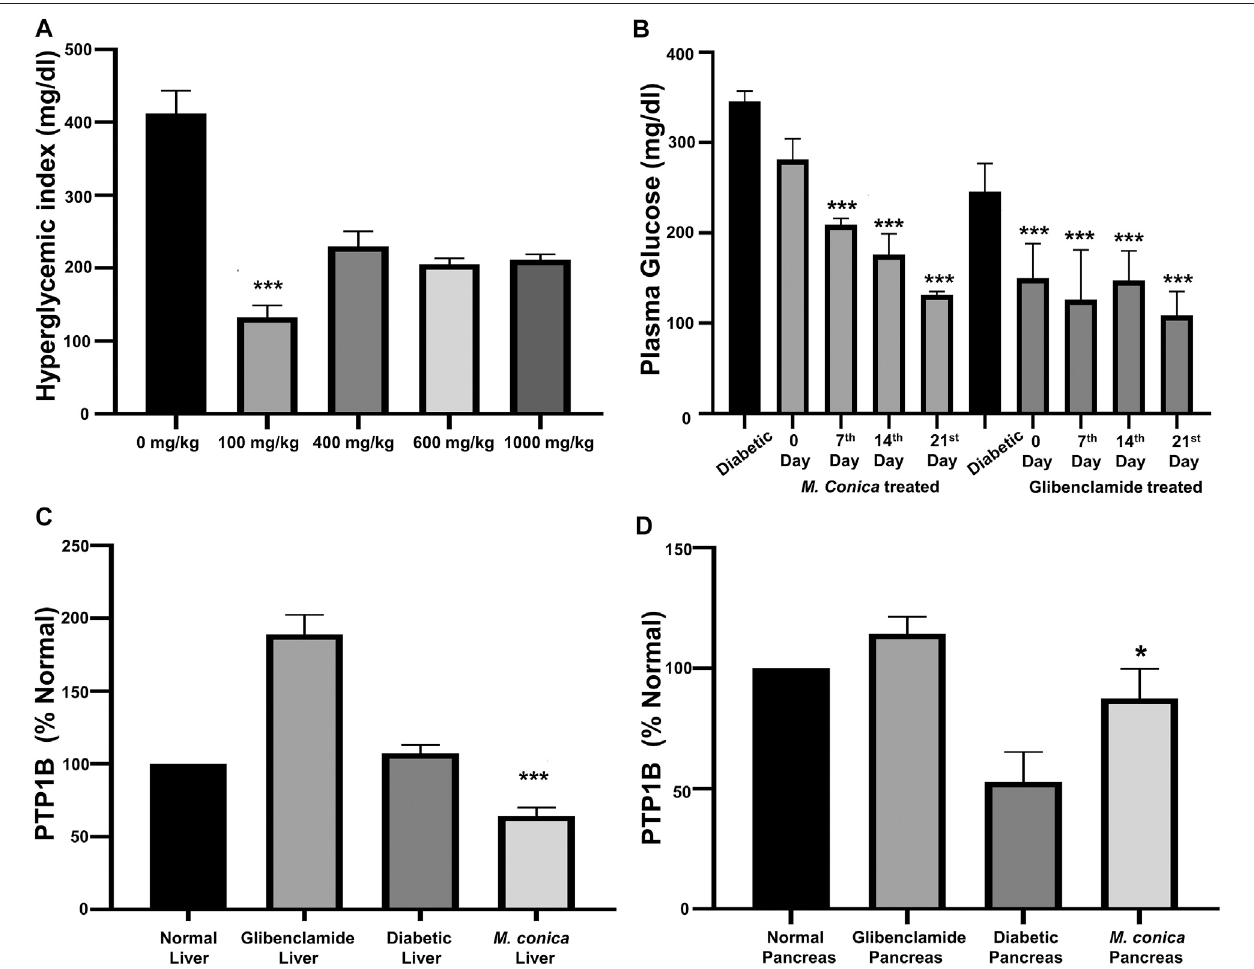
FIGURE 2 | (A) Dose optimization for M. conica to select a fi nal effective dose to be administered which was found to be 100 mg/kg. At this dose the sample showed signi fi cant results at *** p < 0.001. (B) Effect of M. conica on hyperglycemic index compared with glibenclamide treated group. The results are presented as the mean ± SEM of three independent experiments, each of which was carried out in triplicate. The data was analyzed using one-way ANOVA by applying Tuckey test. For M.conica resultswerefoundtobesigni fi cant(*** p < 0.001)from14 daysonward. (C) ComparisonofPTP1Bexpressioninlivertissue*** p (cid:2) 0.001. (D) Comparison of PTP1B expression in pancreas tissue (* p (cid:2) 0.16) of normal mice, diabetic mice and diabetic treated groups with glibenclamide and M. conica . The results are presented as the mean ± SEM of three independent experiments, each of which was carried out in